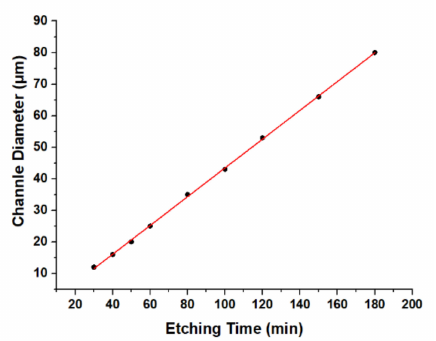
Figure 2. Relation between microchannel diameter and etching